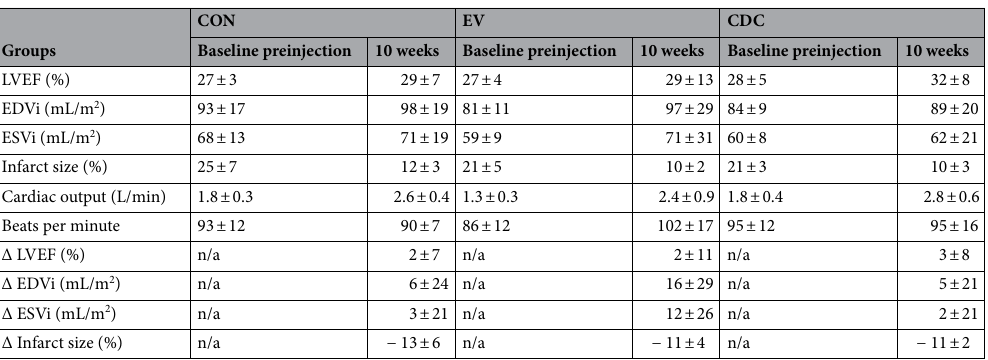
Table 2. Main cardiac parameters calculated from magnetic resonance exams performed throughout the study. Data presented as mean ± standard deviation. LVEF left ventricular ejection fraction, EDVi end diastolic volume indexed to body surface area, ESVi end systolic volume indexed to body surface area. Infarct area is expressed as % of the left ventricle. n/a not applicable.